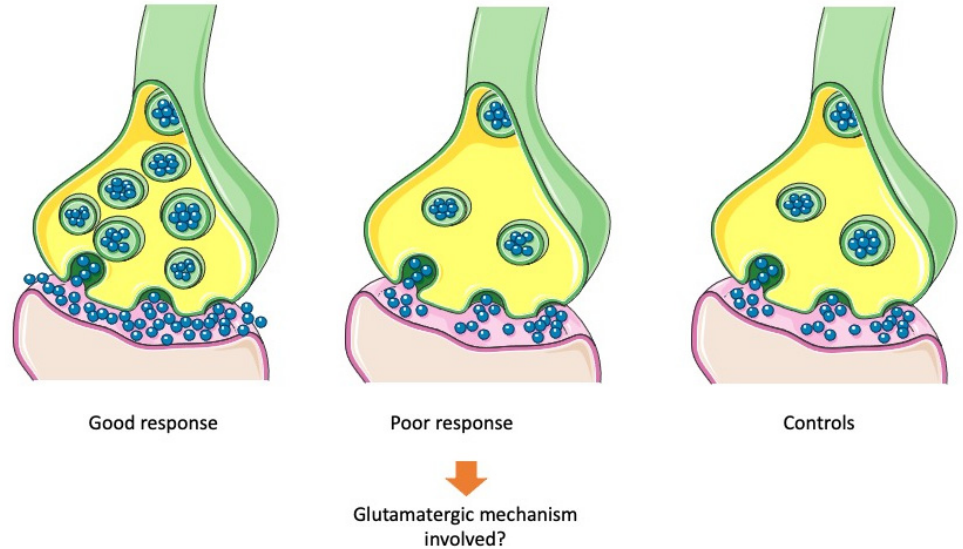
Figure 6. Putative presynaptic molecular mechanisms of treatment resistance. Antipsychotics may bring back abnormally high presynaptic dopamine levels in psychotic patients to physiological levels. Presynaptic hyperdopaminergia is supposed to be a major mechanism of good response to treatment. On the other side, poor response to antipsychotic treatment in treatment resistant patients has been associated with non-significantly different levels of presynaptic dopamine compared to non-affected controls.